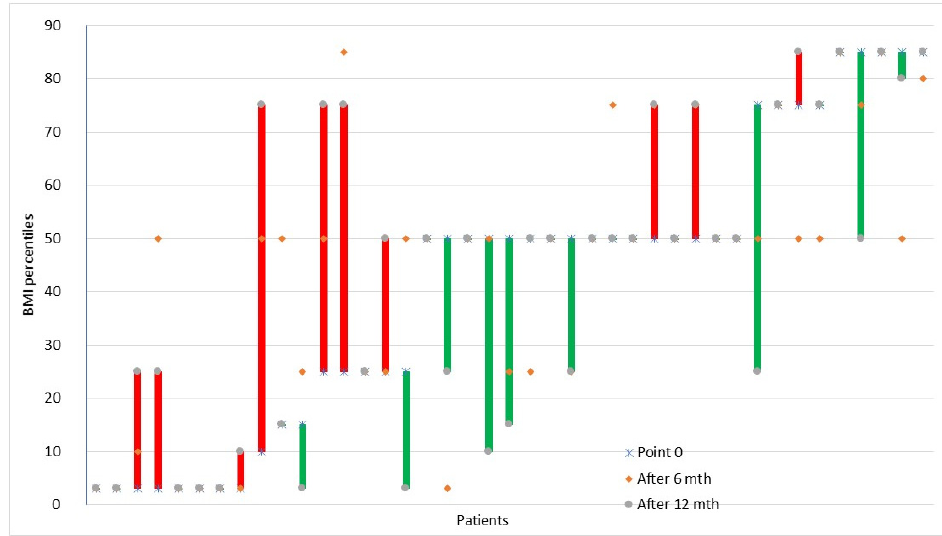
Figure 2. Changes in individual children’s BMI percentiles in time. The lines describe the BMI per- centile change individually for each child between three time points: before diagnosis (point 0) and after 6 and 12 months. Red means increase and green means decrease.